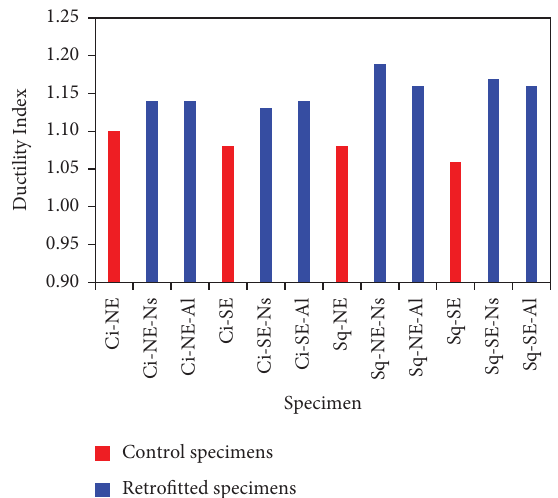
Figure 11: Comparing the ductility of columns in diferent states.